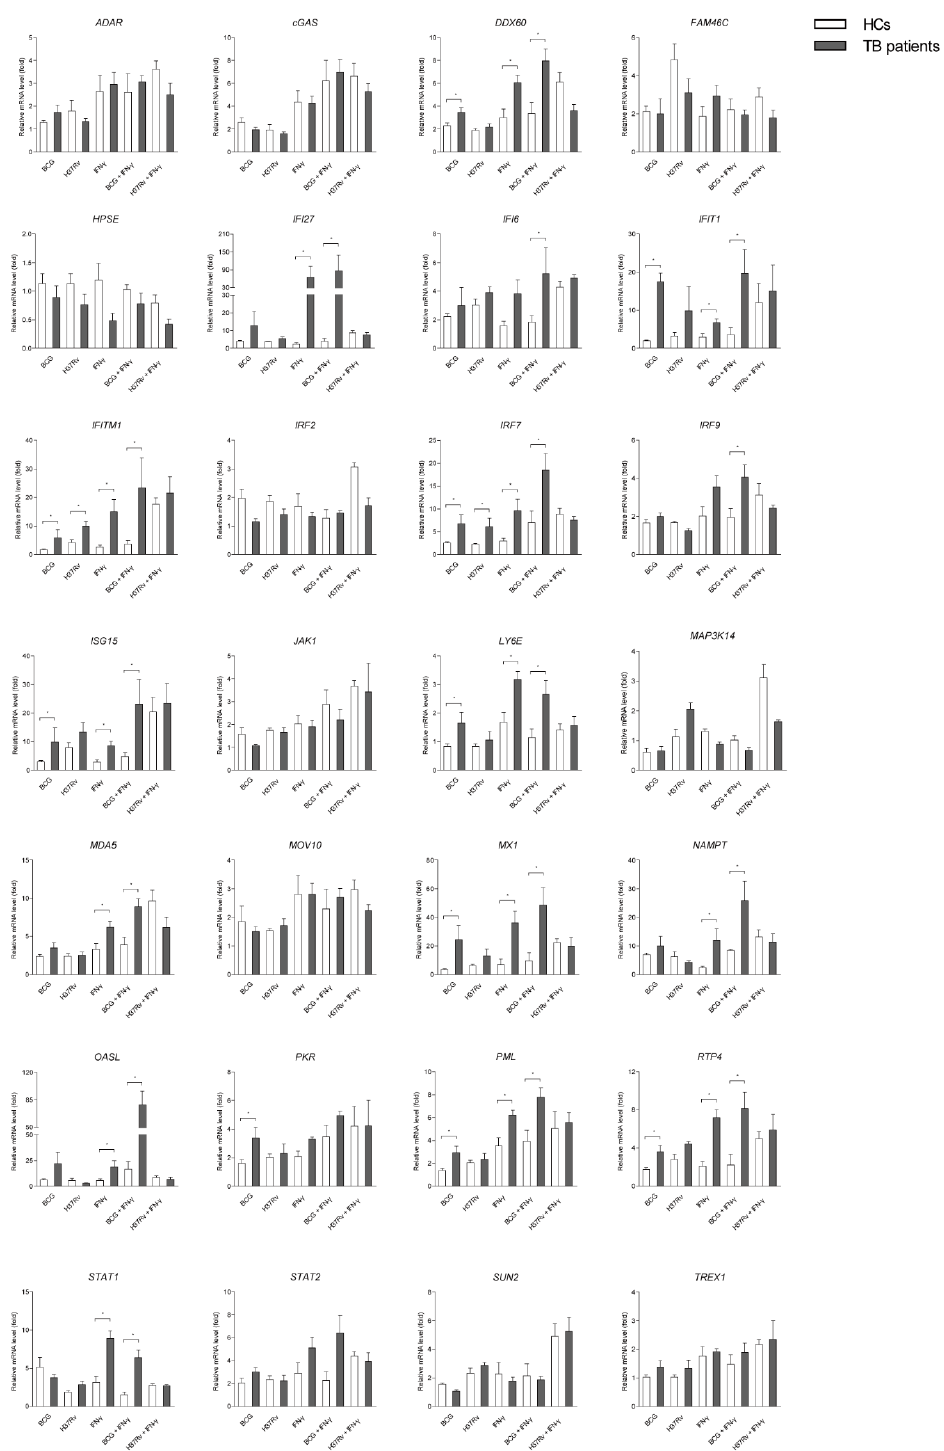
Figure 4. A number of ISGs in hMDMs derived from TB patients are more susceptible to mycobacterial infection and IFN- γ treatment than that from HC. 28 ISGs in hMDMs derived from TB patients (gray columns) and HC (white columns) have been detected by qRT-PCR with BCG infection, H37Rv infection (MOI = 2) or/and IFN- γ treatments (100 ng/mL) for 24 h. Data are expressed as mRNA fold change relative to untreated cells. GAPDH served as an internal reference. (Data presented as mean ± SEM, n = 3 independent experiments with each 1–2 replicates). * p < 0.05 and ** p < 0.01 were considered as statistically